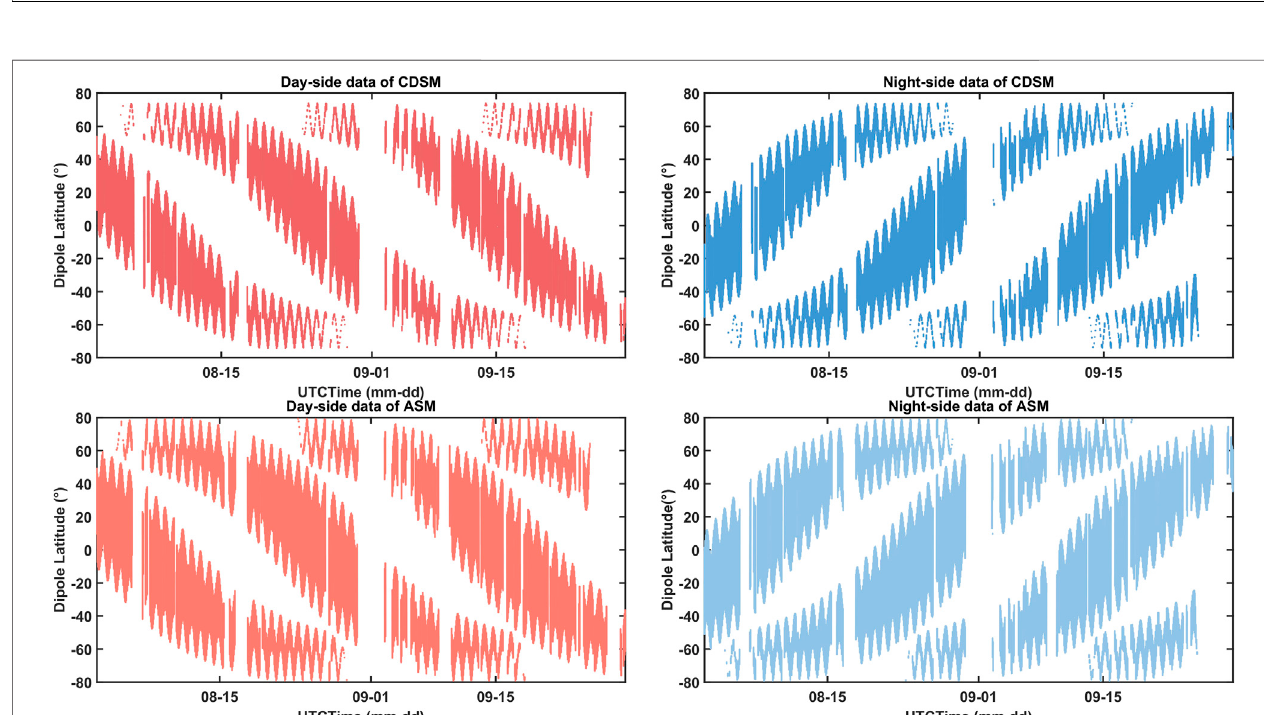
FIGURE 2 | Data distribution of the CDSM and ASM for the period from 31 July 2019 to 30 September 2019 after the data screening.